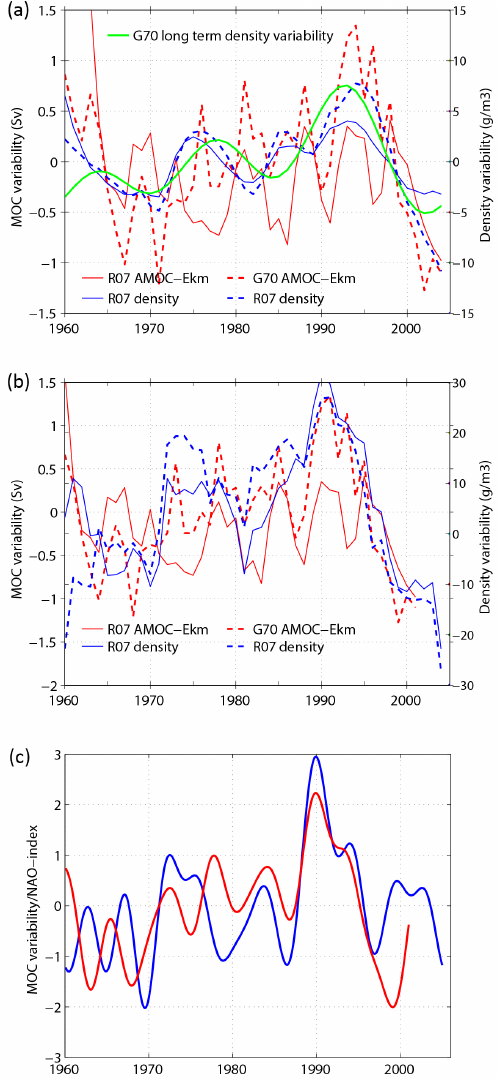
Figure 4. Annual time series of AMOC-Ek transport anomaly at 26.5 ◦ N (red) and density anomaly (blue) averaged over the Labrador and Irminger seas (between 50–35 ◦ W and 45–60 ◦ N) in 1000–3000m layer (a) and in the top 1000m (b) . Thin solid and thick dashed lines correspond to ORCA1-R07 and ORCA025-G70 runs, respectively. Long-term (after use of low-pass filter with pe- riods longer than 13 years) ORCA025-G70 density variability in 1000–3000m layer is shown by green solid thick line in Fig. 4a. The AMOC plots in Fig. 4b lag at 48 months compared to density curves; (c) – NAO index (blue) and AMOC-Ek variability at 26.5 ◦ N (red) after low-pass filtering with periods longer than 48 months and normalized to unit variance to have zero mean and a standard devi- ation of one; here AMOC time series is shifted 48 months back relative to the NAO index. To make panels (a) and (b) more read- able, shorter names R07 and G70 for legend have been used for the experiments ORCA1-R07 and ORCA025-G70